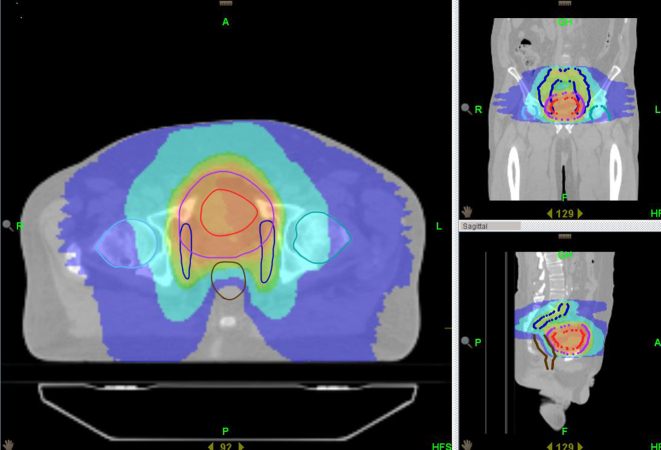
Tomotherapy plan.